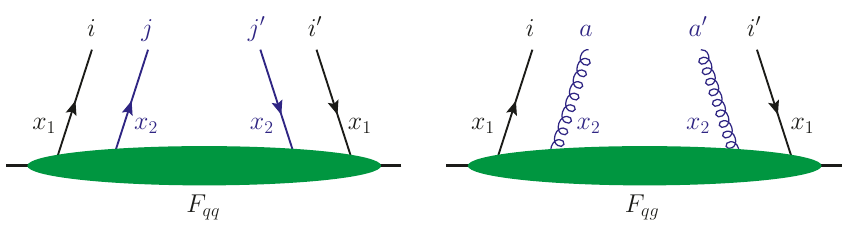
Figure 1 . Assignment of colour labels for a two-quark distribution (left) and a quark-gluon distribution